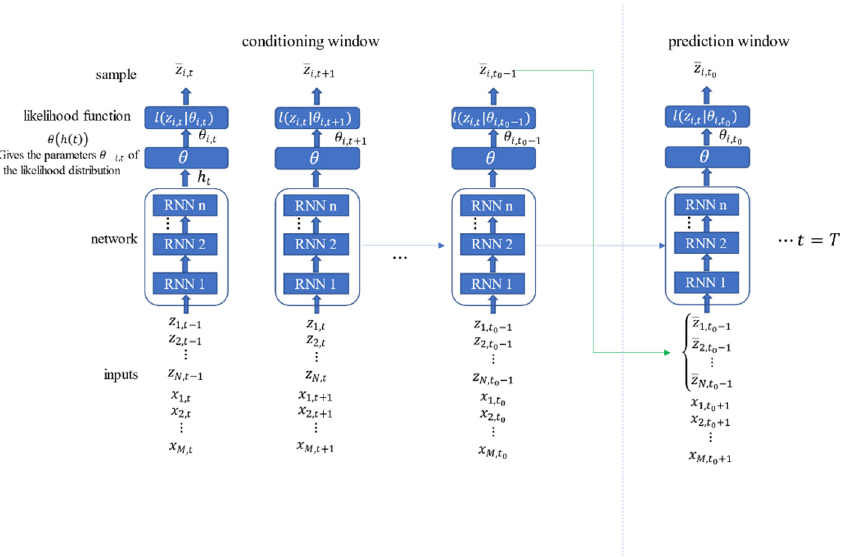
Figure 4. Forecasting process of DeepAR.